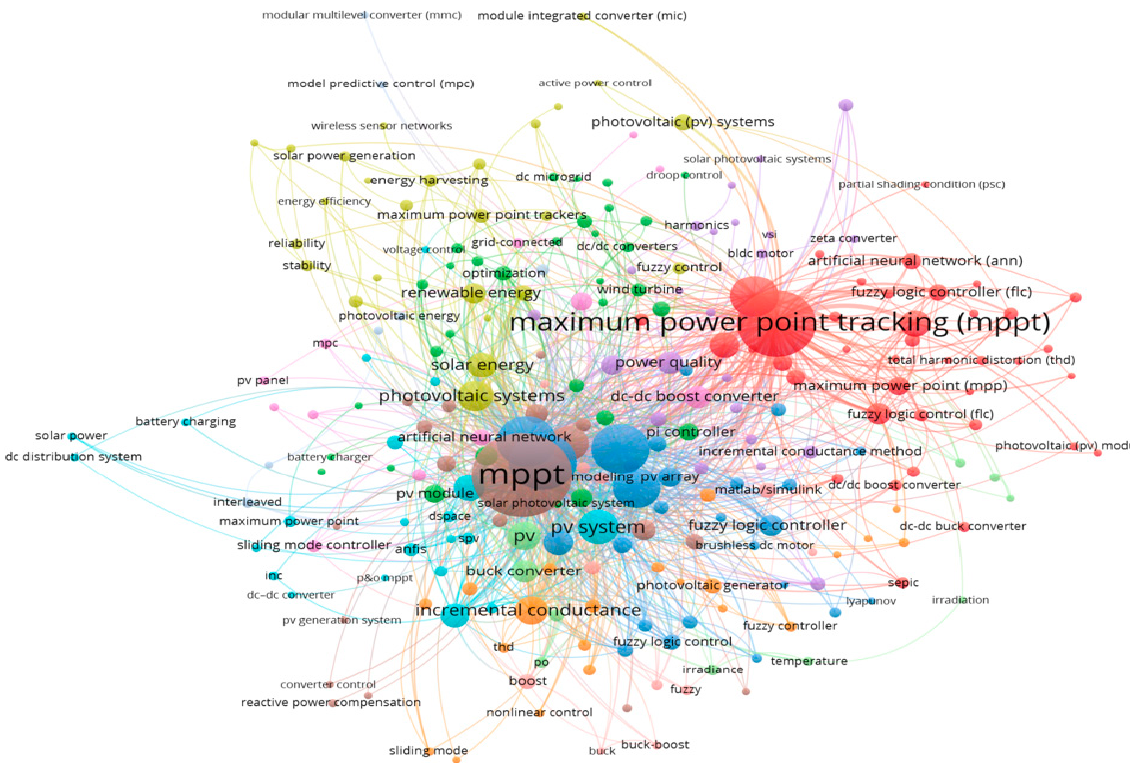
Figure 5. Analysis of the author-supplied keywords from 2005 to 2022.